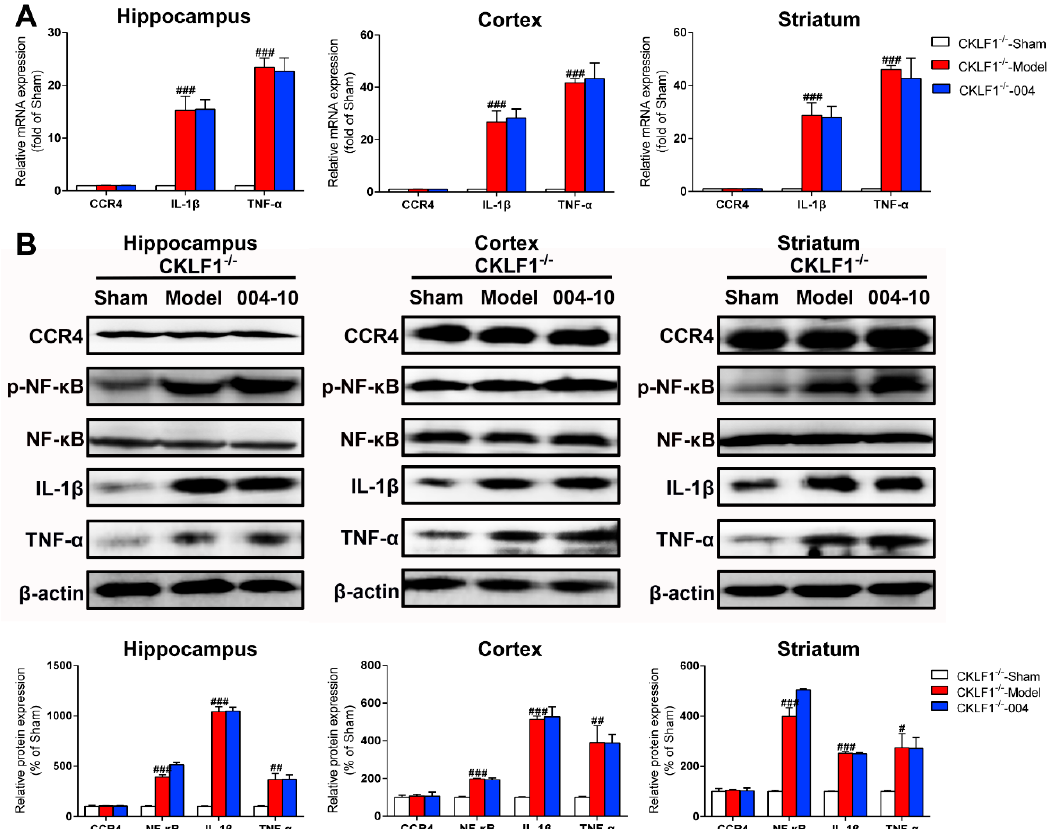
Figure 14. CKLF1 is necessary for IMM-H004 to anti-inflammation in ischemic brain. ( A ) RT-PCR analysis for Effect of IMM-H004 on expression levels of CCR4, IL-1 β , and TNF- α in the hippocampus, cortex, and striatum of CKLF1 − / − rats. ( B ) Western blot analysis for Effect of IMM-H004 on expression of CCR4, p-NF- κ B, NF- κ B, IL-1 β , and TNF- α in the hippocampus, cortex, and striatum of CKLF1 − / − rats. All the data are shown as the mean ± SD, a part of data are shown as the mean ± SD after normalization to the sham ( n = 6/group). # p < 0.05 vs. sham; ## p < 0.01 vs. sham; ### p < 0.001 vs. sham.